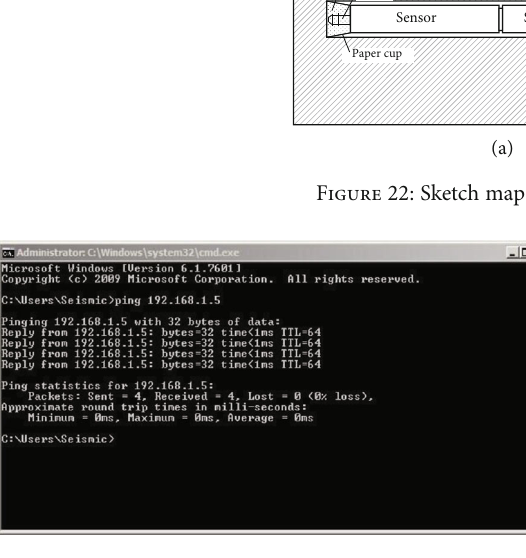
Figure 23: Workstation delay monitoring results.